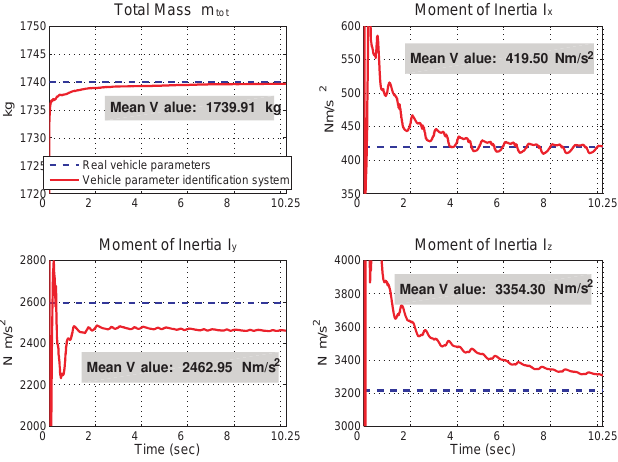
Figure 6. The identification of the vehicle mass and moment of inertia. The mean values are calculated from the 15th second to the 10th second.